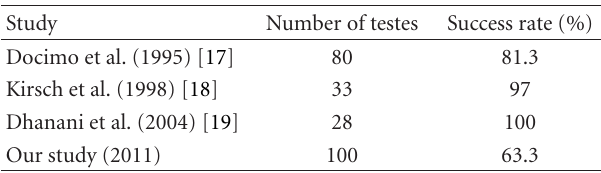
Table 2: Total success rate of orchiopexy in our study and in previous